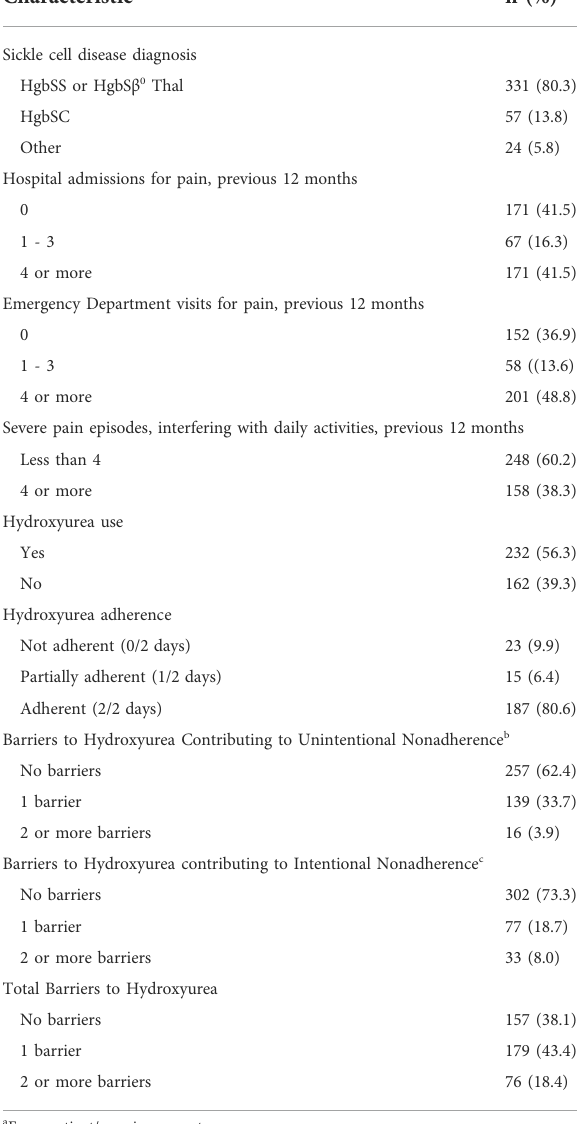
TABLE 2 Clinical characteristics, barriers to care and health behaviors ( N = 412) a